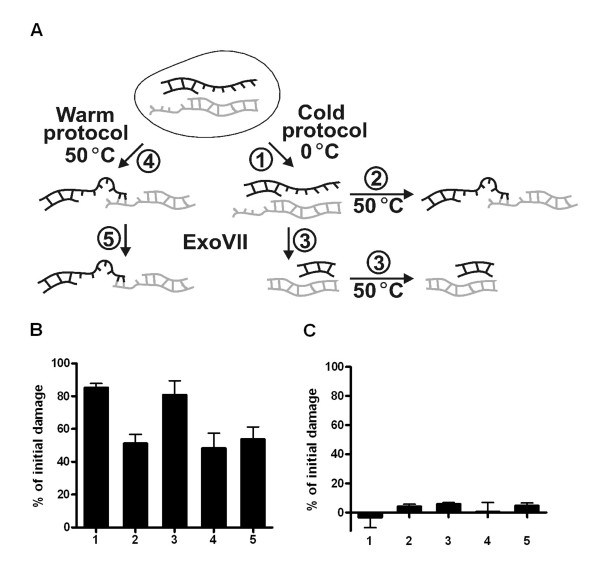
ssDNA end formation at DSBs in NHEJ deficient cells. Cells 24 h after irradiation were treated in five different ways (A): 1. Cold DNA extraction; 2. Cold DNA extraction + 18 h at 50°C; 3. Cold DNA extraction + ExoVII + 18 h at 50°C; 4. Warm DNA extraction; 5. Warm DNA extraction + ExoVII. In (B) and (C) the relative amount of initial damage in the NHEJ deficient M059J cell line and the NHEJ proficient M059K cell line, respectively are shown after the different treatments outlined in A. The level of damage at 0 h with the cold DNA extraction protocol was set to 100%. The error bars represent the SD of three experiments (M059J) or the maximum deviations of two experiments (M059K).